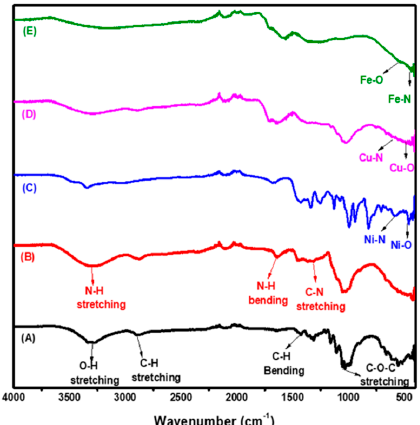
Figure 1. Fourier transform-infrared spectroscopy (FT-IR) spectra for ( A ) Cellulose, ( B ) aminated cellulose (Acell), ( C ) nNiO/Acell, ( D ) nCuO/Acell and ( E ) nFe 3 O 4 /Acell nanocomposite.